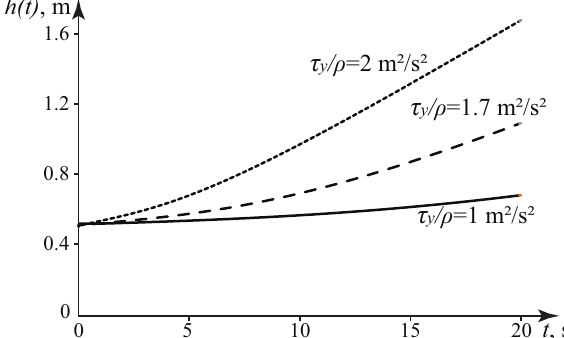
Figure 16. h versus t for flows of the Herschel–Bulkley fluid with different yield stresses τ y . The other parameters are the same for three given variants and correspond